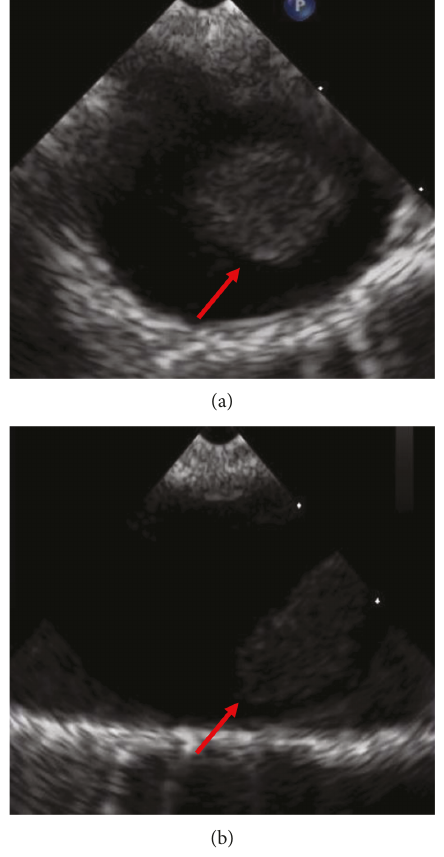
Figure 4: (a) Transesophageal echocardiogram (transverse view) of a large mass attached to the wall of the descending thoracic aorta. (b) Transesophageal echocardiogram (longitudinal view) of the large mobile mass attached to the aortic anticardiolipin antibodies ( × 2), homocysteine levels, parox- ysmal nocturnal hemoglobinuria screening, Protein C and S activity, antithrombin mutations, and factor V Leiden and